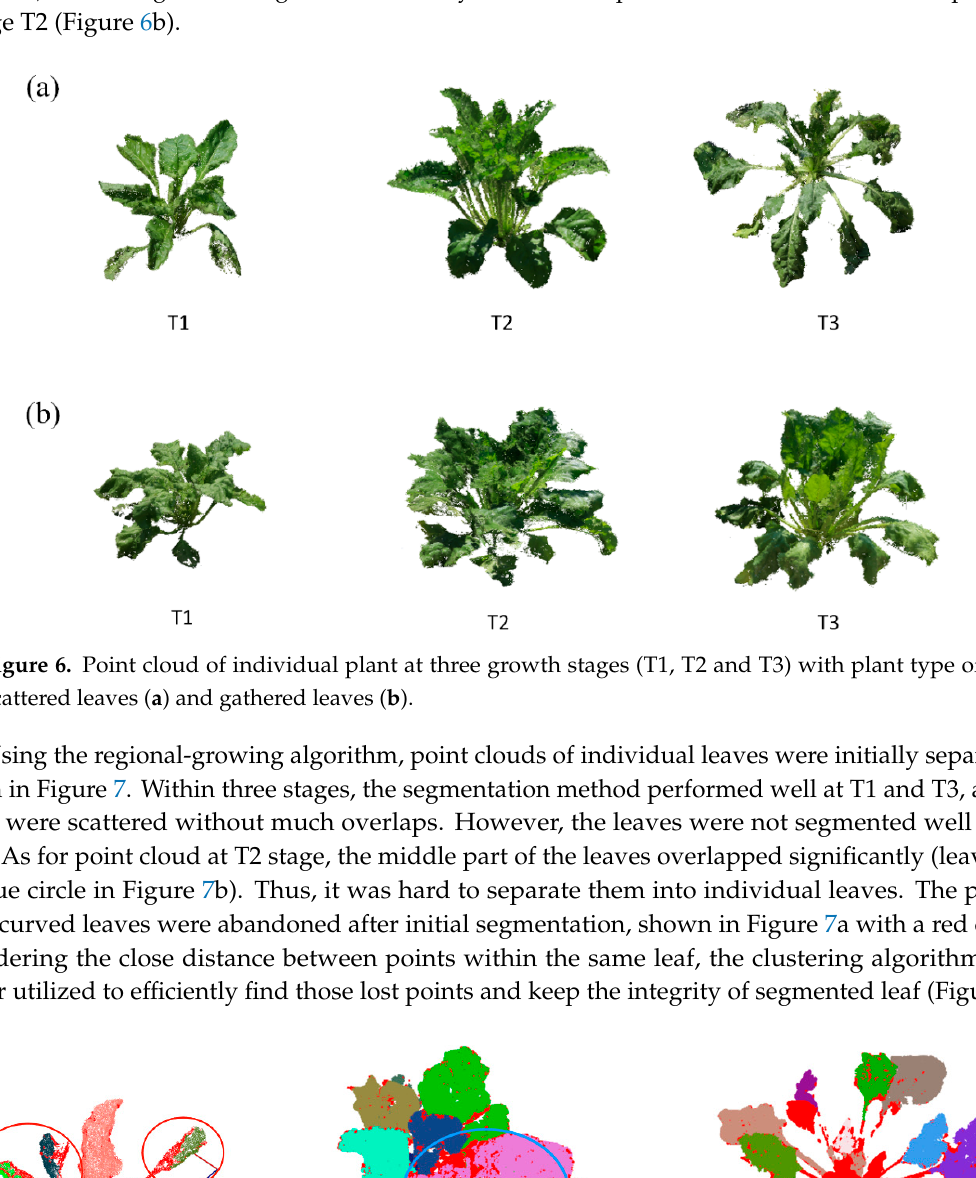
Figure 7. Point cloud segmentation of sugar beet into individual leaves at ( a ) T1, ( b ) T2 and ( c ) T3 growth stages using regional-growing algorithm. Different colors represent individual leaves at different position on the plant. The red points on each leaf were discarded points at the first segmentation. Leaves in red circle were the curved leaves which lost many points after segmentation. Leaves in blue circle were overlapped with each other at stage T2 and cannot be segmented properly into individual leaves.